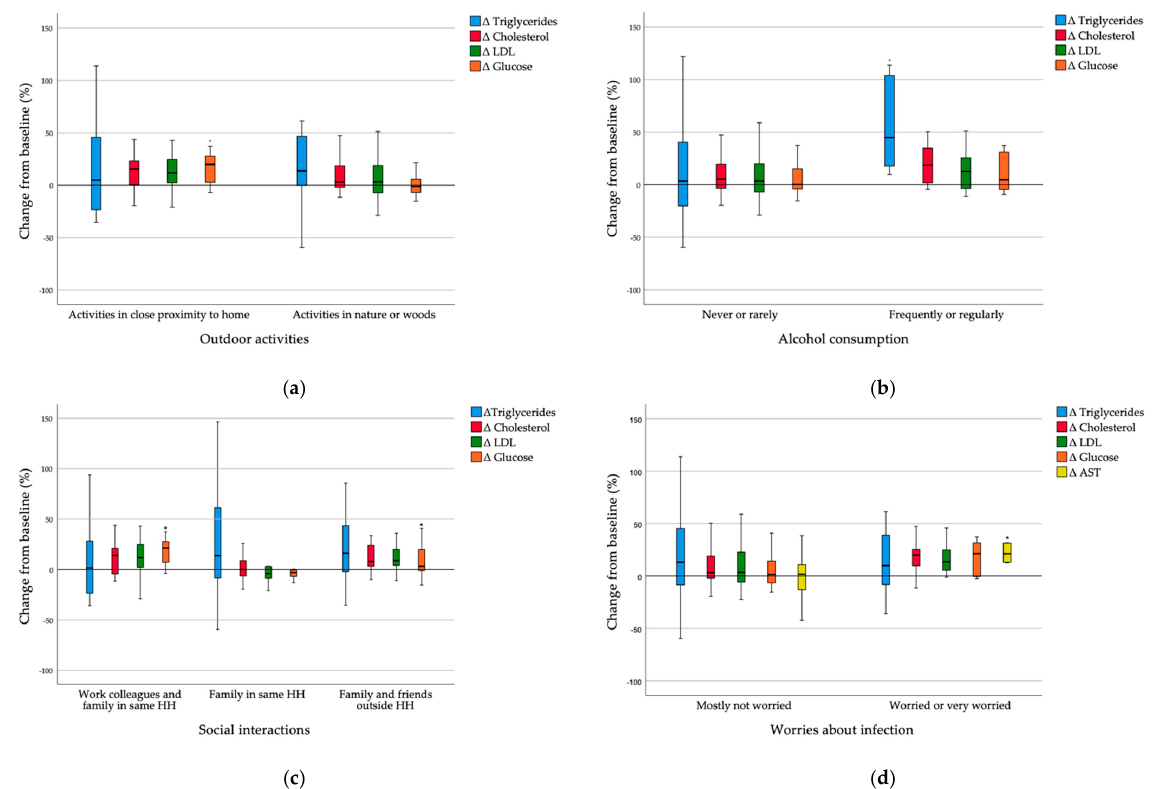
Figure 2. ( a ) Δ serum markers in groups with different outdoor activities during lockdown; ( b ) Δ serum markers in groups with different alcohol consumption during lockdown; ( c ) Δ serum markers in groups with different social interactions during lockdown; ( d ) Δ serum markers in groups with different levels of worries about infection during lockdown. Δ —change of post-lockdown value from baseline; LDL—low-density lipoprotein; AST—aspartate transaminase; HH—household . * p < 0.05 is considered statistically significant.